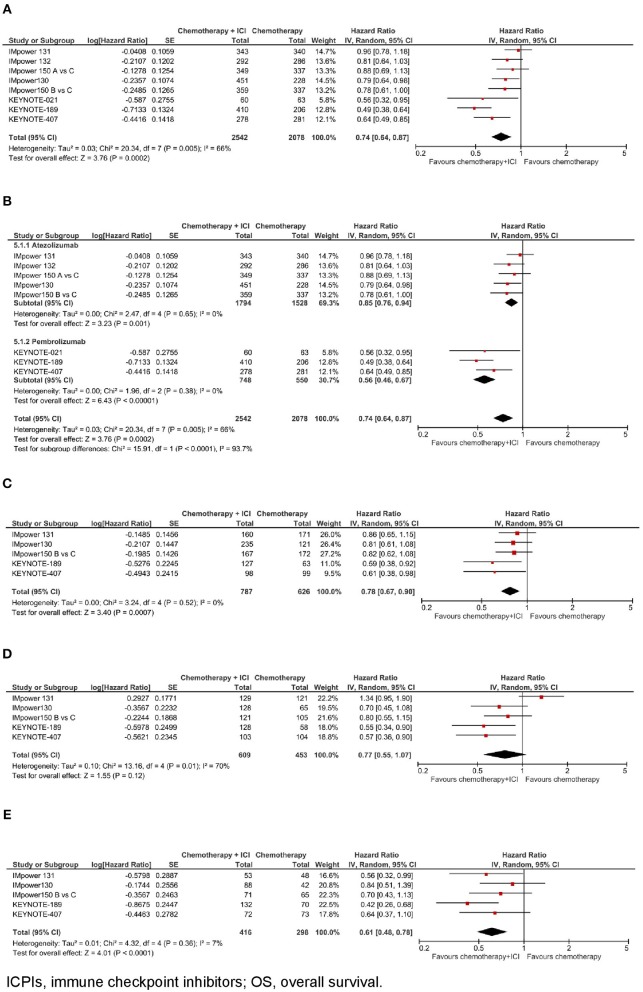
Overall survival with chemotherapy plus ICPIs. (A) OS in whole study population. (B) OS by ICPI administered. (C) OS by PD-L1 expression- PD-L1 negative. (D) OS by PD-L1 expression- PD-L1 low. (E) OS by PD-L1 expression- PD-L1 high.